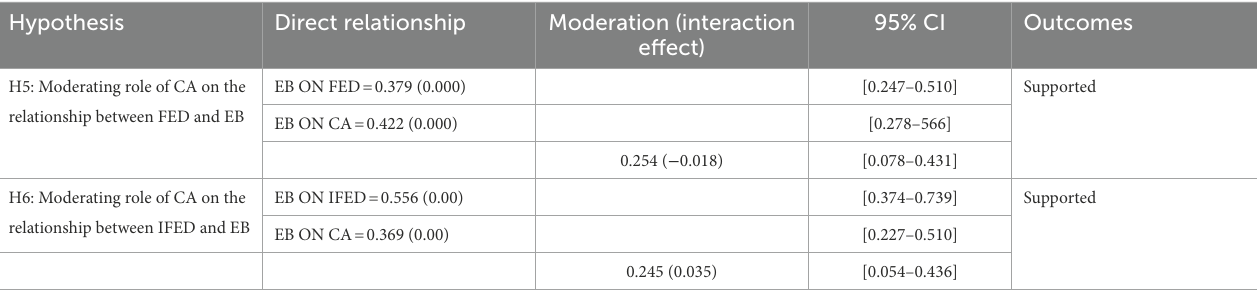
TABLE 7 Hypothesis testing for moderation analysis.